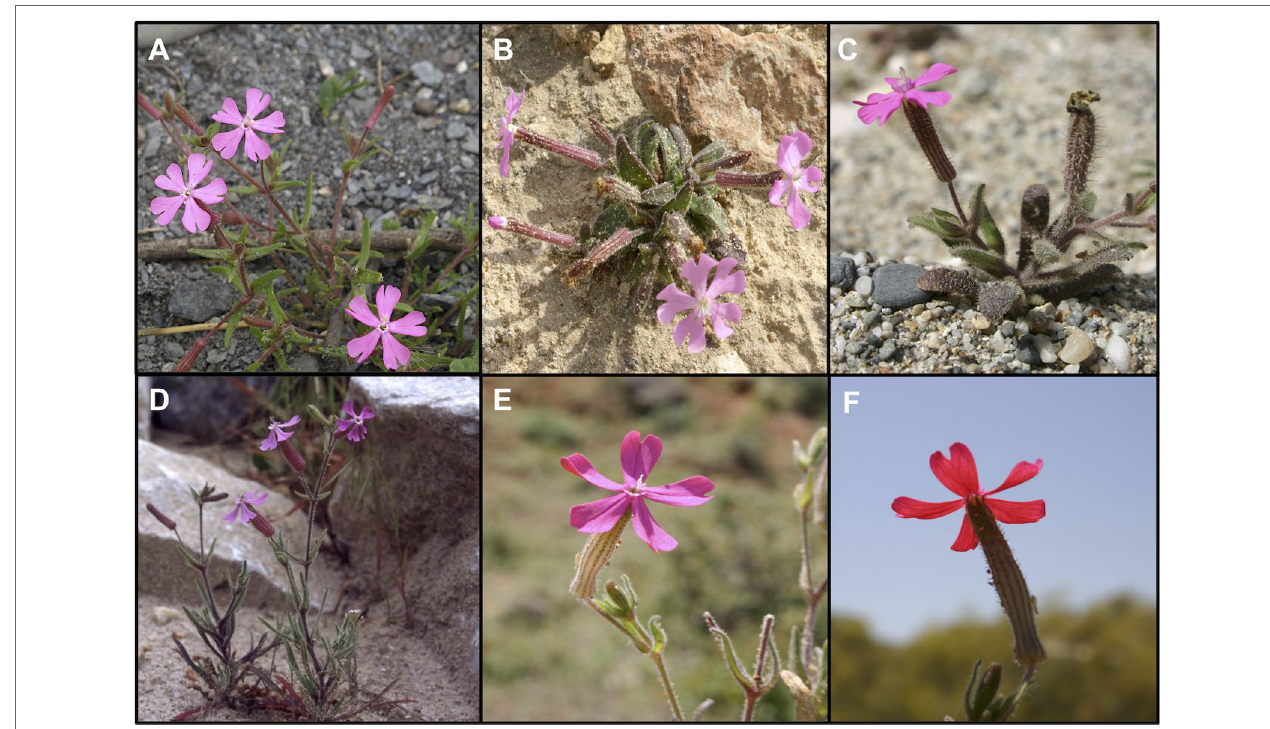
FIgURe 1 | Photographs of the five species belonging to Silene section Psammophilae . (a) Silene adscendens , (B) Silene cambessedesii , (c) Silene littorea , (D) Silene psammitis , and (e , F) Silene stockenii (showing the characteristic upper and lower side of petals).